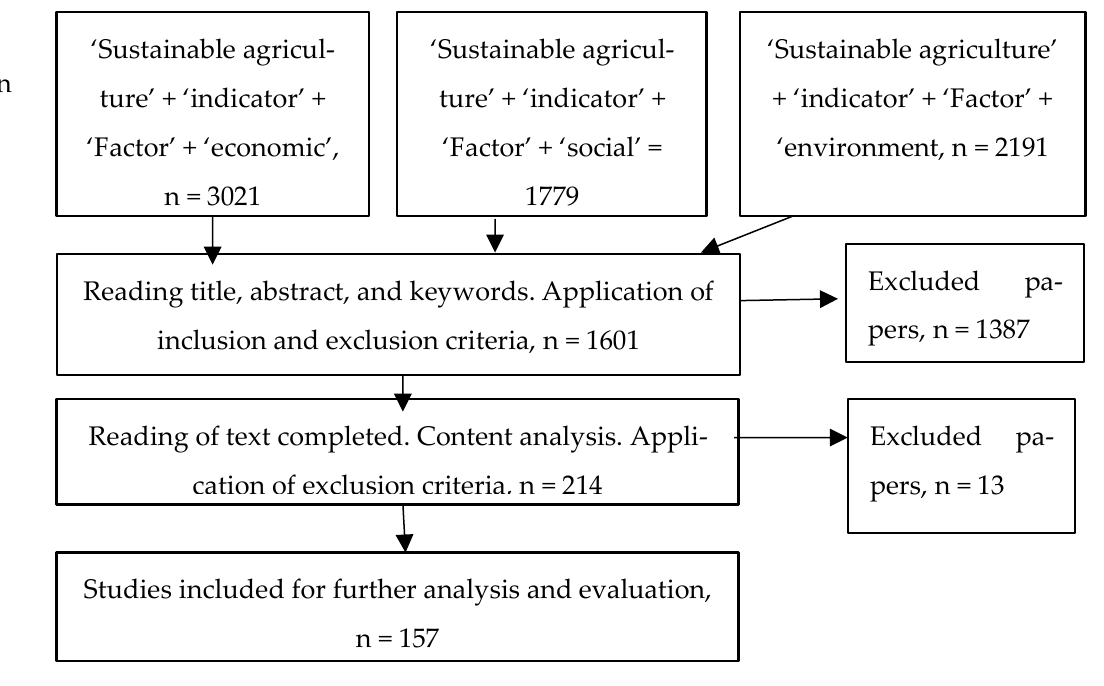
Figure 3. PRISMA steps for the appraisal Figure 3 . PRISMA steps for the appraisal phase .